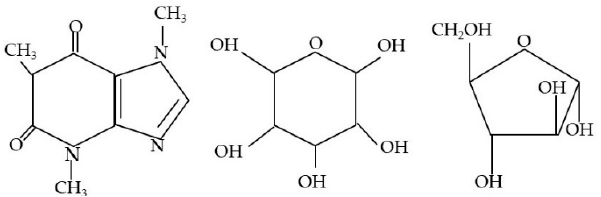
Figure 3. Chemical structure of caffeine, glucose and arabinose (from left to right).